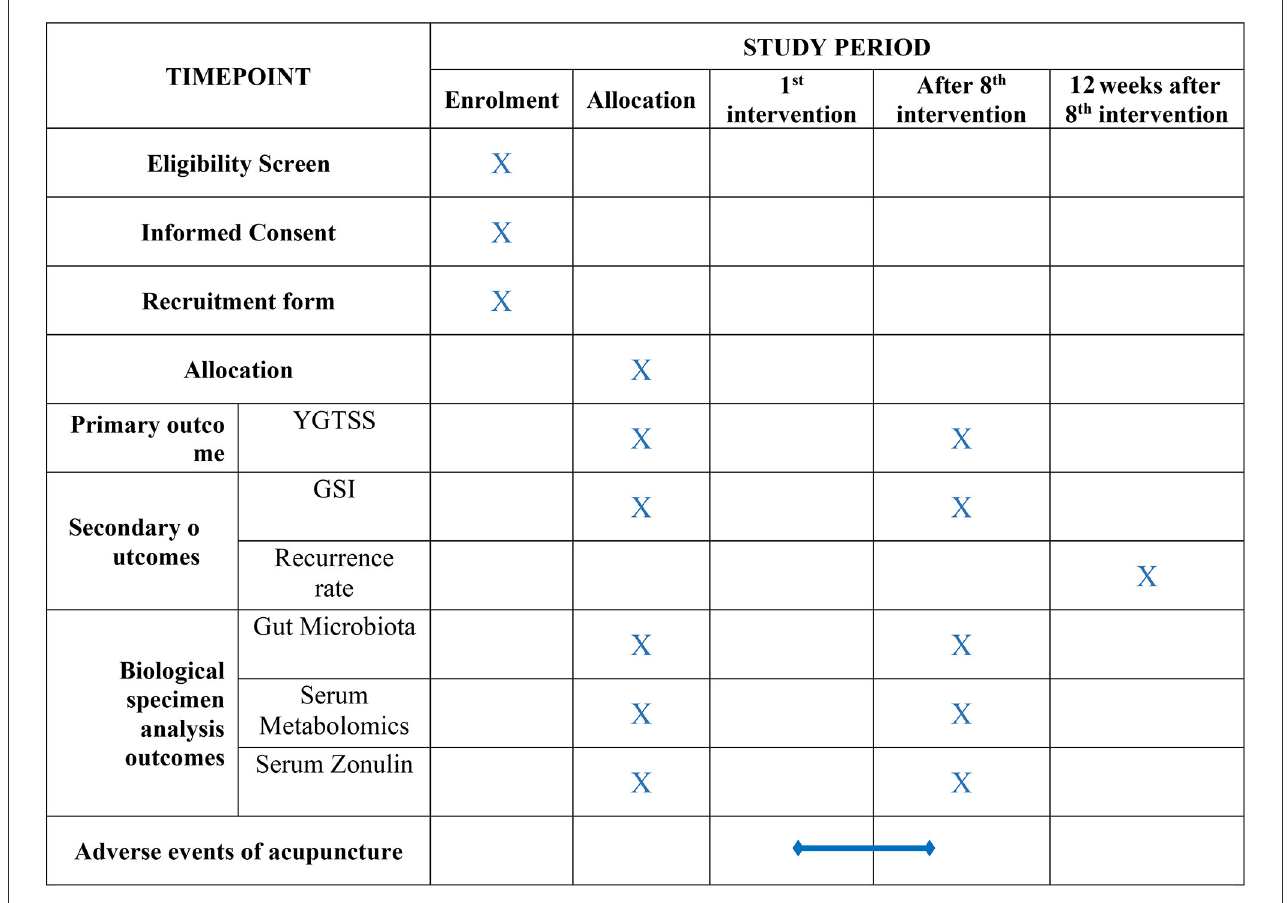
FIGURE2 Schedule of trial enrollment, interventions, and